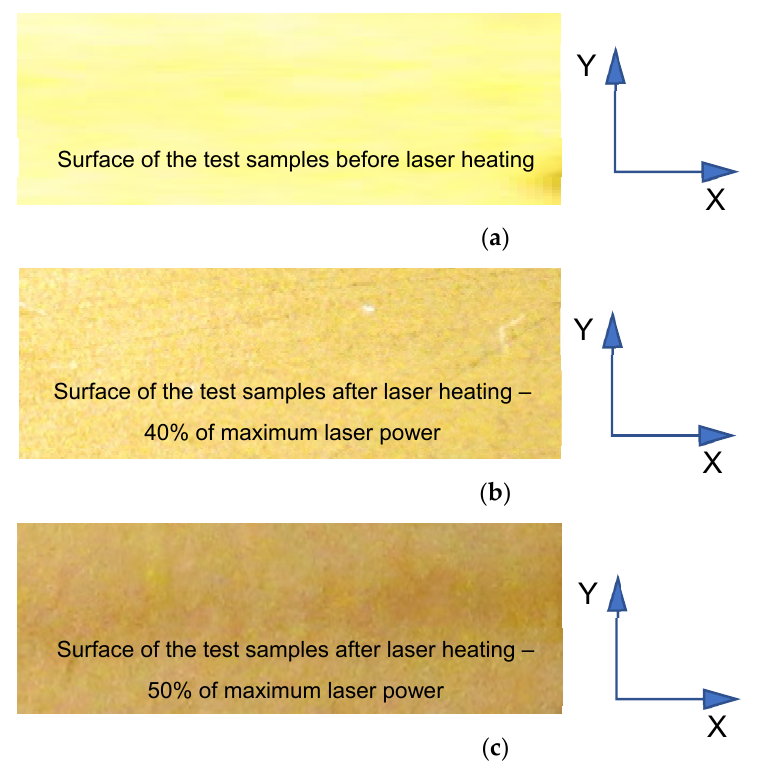
Figure 19. Images showing the surface of the samples before ( a ) and after laser heating with ( b ) 40% and ( c ) 50% of maximum laser power.